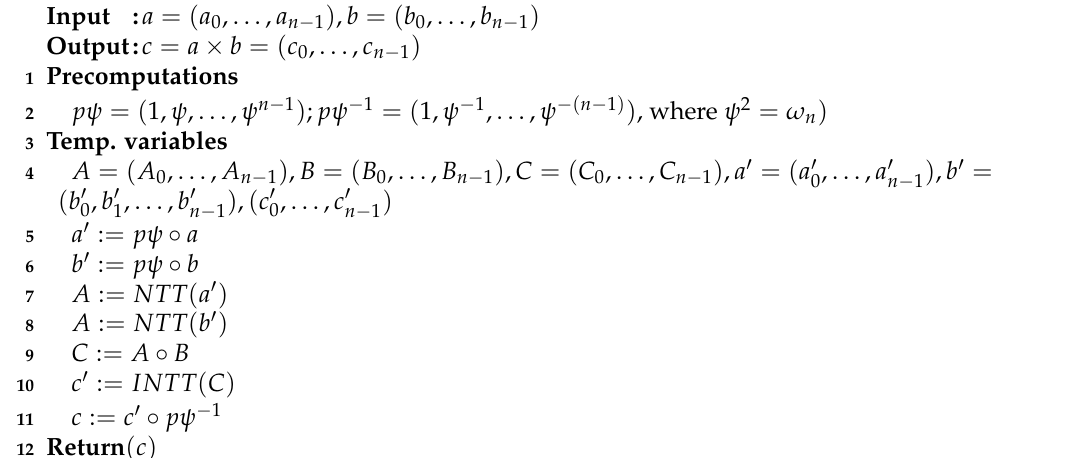
Algorithm 1: Number theoretic transform (NTT)-based polynomial multiplication using negative wrapped